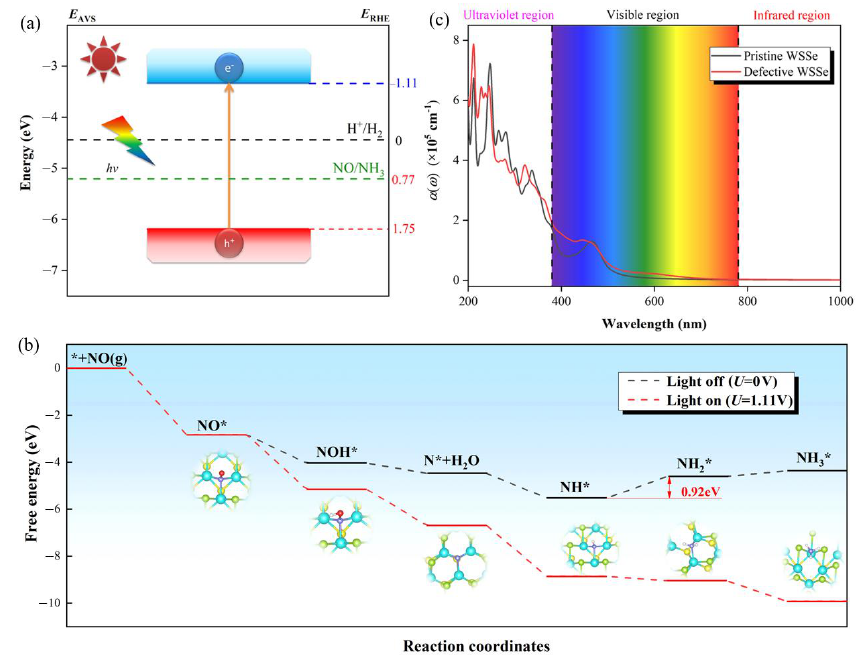
Figure 7. ( a ) A schematic representation of the Janus WSSe monolayer’s band edge positions in re- lation to the reversible hydrogen electrode (RHE) at pH = 0. * stands for the adsorption site at the surface of catalyst. Relative energy levels to the absolute vacuum scale (AVS) and RHE are repre- sented by E AVS and E RHE . ( b ) Gibbs free energy diagrams of NORR to NH 3 on defective Janus WSSe monolayer under U = 0 and U = 1.11 V. The applied potential that a photo-excited electron provides is U = 1.11 V. ( c ) The Janus WSSe monolayer’s optical absorbance in both pristine and defective states.